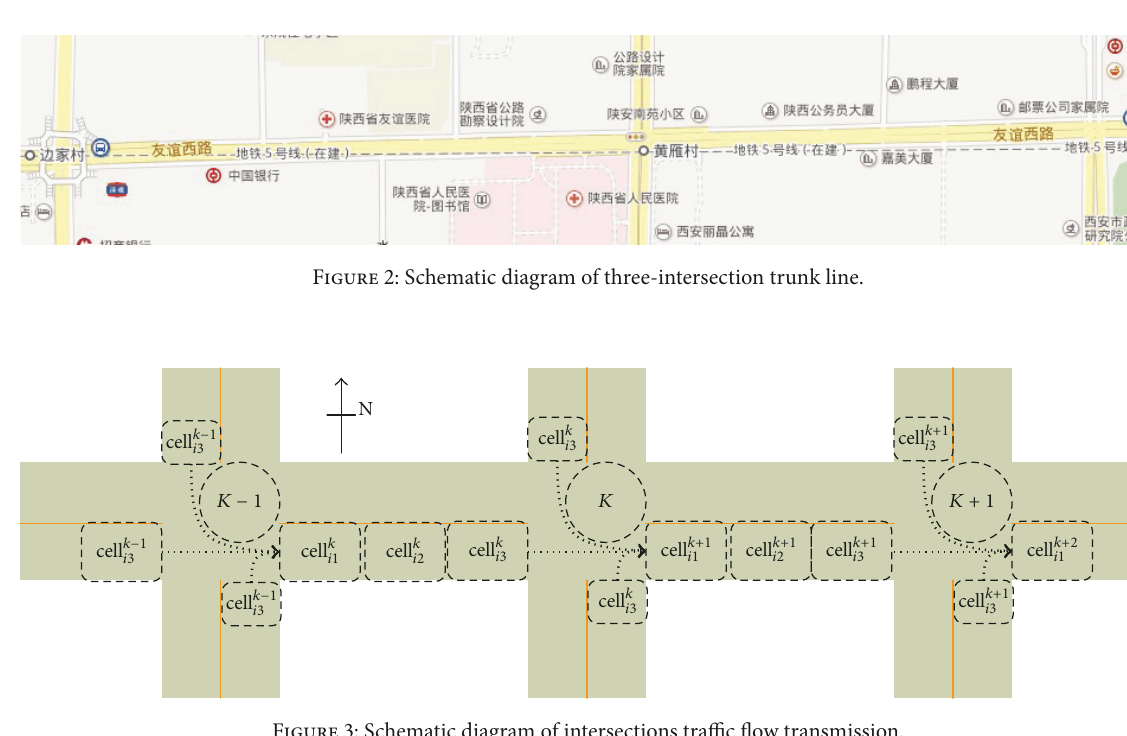
Figure 3: Schematic diagram of intersections traffic flow